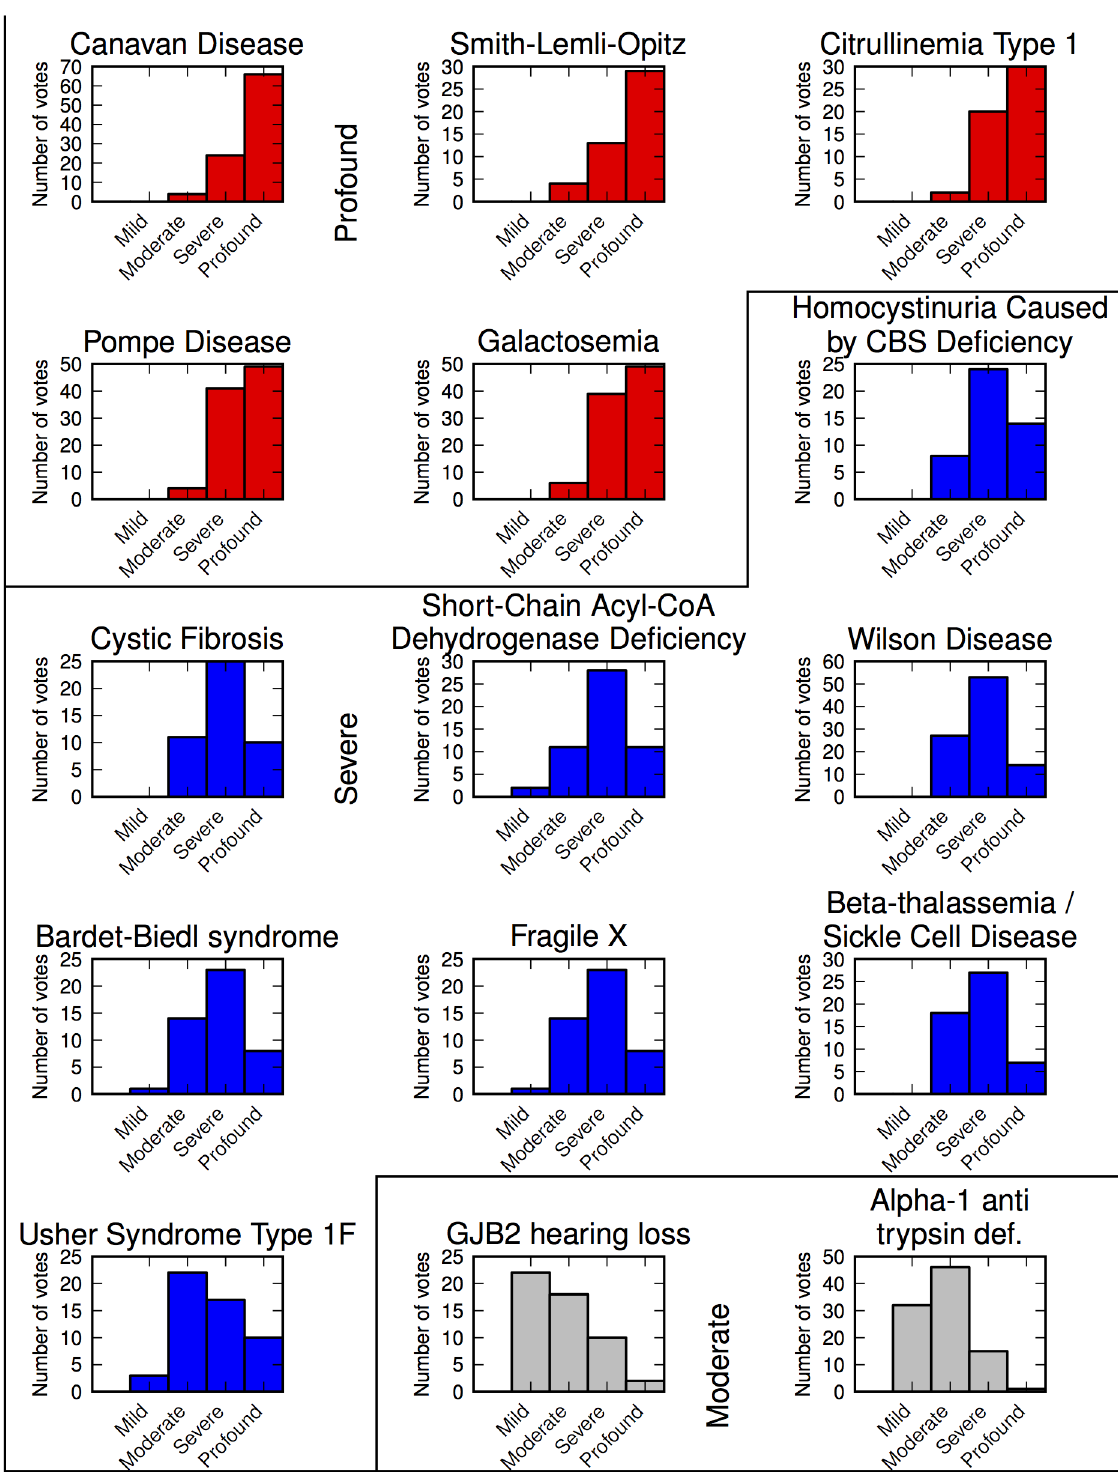
Fig. 3. Distribution of disease severity